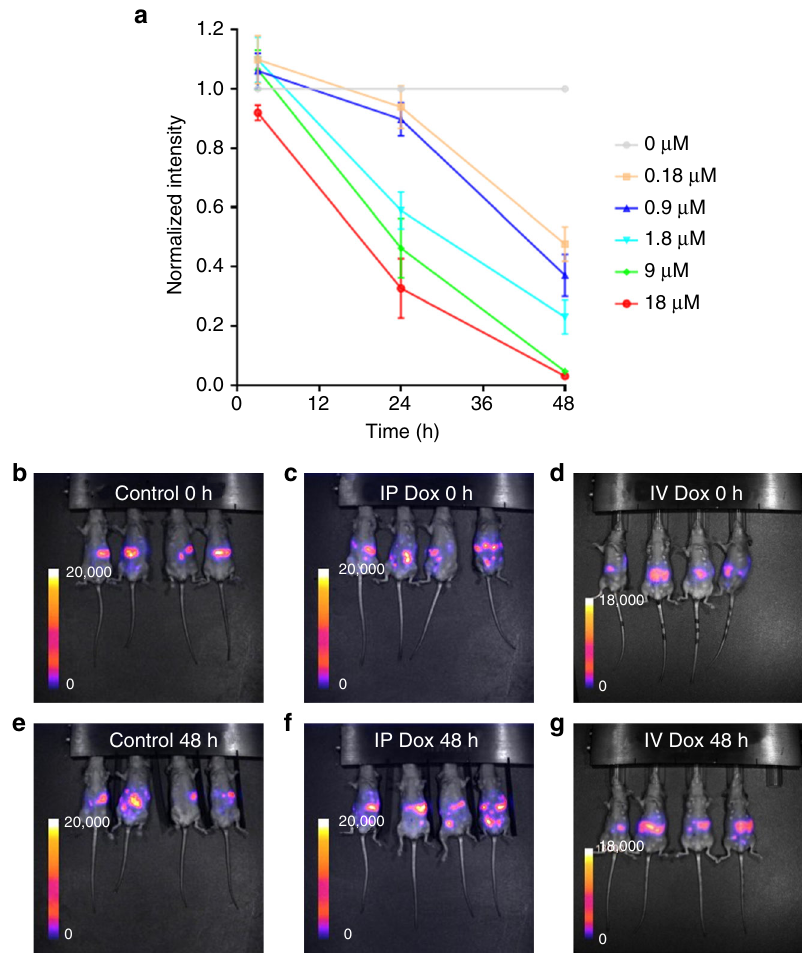
Fig. 7 Differential doxorubicin ef fi cacy in vivo and in vitro. a Chart shows effect of 0, 0.18, 0.9, 1.8, 9, and 18 μ M doxorubicin treatment on the viability of IGROV-1 stably expressing luciferase in vitro. Viability was assessed by luciferase activity in 24-well plate (1 × 10 5 cells well − 1 ). Each data point represents the average intensity relative to that for 0 μ M plotted at time = 0 h. The error bars represent the s.d. for n = 3 biological replicates i.e., three 24-well plates. b – g images show the effect of doxorubicin on IGROV-1 tumor burden in vivo. b – d show luciferase imaging of mice immediately (0 h) following control ( b ), intraperitoneal ( c ) or intravenous ( d ) injection with control PBS or 5 mg kg − 1 doxorubicin. e – g show the corresponding sets of mice 48 h postinjection. Biological replicates of n = 4 mice were used for each luciferase imaging fi ber aperture acted as a pinhole for excitation light in a confocal arrangement with a photomultiplier. A dichroic beamsplitter re fl ected laser light to the commercial endoscope optical scanning unit and transmitted returning fl uorescence to the photomultiplier (PMT, PMH 100-1, B&H). In the commercial scanning unit, a 4 kHz resonance mirror provided the fast line scan direction and a galvanometric mirror operating at 8.5Hz provided the slow scan direction (i.e., a frame rate of 8.5 Hz). The focused laser spot is raster-scanned across the distal end of the CEM ’ s coherent fi ber bundle. A prototype Cellvizio ® Mini O probe designed for minimal auto fl uorescence background was used 41 . The coherent fi ber-optic bundle consists of ~30,000 cores with a core-to-core spacing of ~3 µm and core diameters of ~2 µm. A mini objective at the probe ’ s distal end results in a fi nal (manufacturer speci fi ed) lateral and axial resolution of 1.4 µm and 10 µm, respectively, and a fi eld of view of 240 µm and working distance of 60 µm when used in the intended con fi guration (i.e., using the internal laser light and detector). The diameter of the distal tip is 2.6 mm. For FLIM, the PMT signals and line and frame clocks from the scanning unit electronics and laser were fed to a SPC-830 TCSPC card (B&H) to register detected fl uorescent photons ’ arrival times and spatial positions on the fi ber-optic bundle end face. One computer controlled the commercial scanning system, and another controlled the FLIM system including the laser and TCSPC electronics. For live FLIM updates, FIFO acquisition mode was used and in-house written software, including a graphical user interface (GUI), was used to compile photon events into an image at an update rate of 8.5Hz. For each measurement, at least 30 s of FLIM data was recorded, with a subset of 85 well-aligned frames (corresponding to 10 s of FIFO TCSPC data) being used for subsequent FLIM